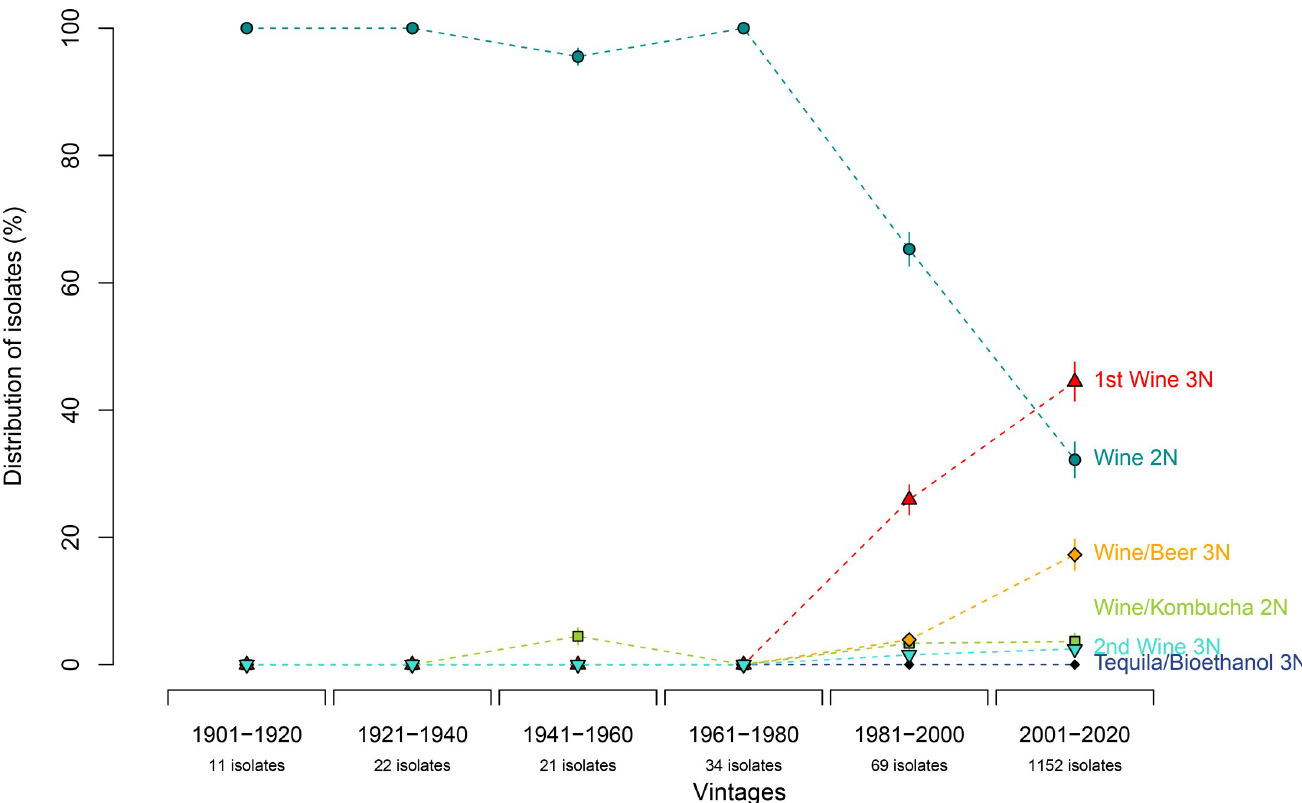
Fig 3. Distribution of B . bruxellensis wine isolates from different genetic groups over vintages. 20 years-intervals were used. In order to calculate confidence intervals, 100 bootstraps were performed (re-sampling of the population). Error bars correspond to 95% confidence interval.